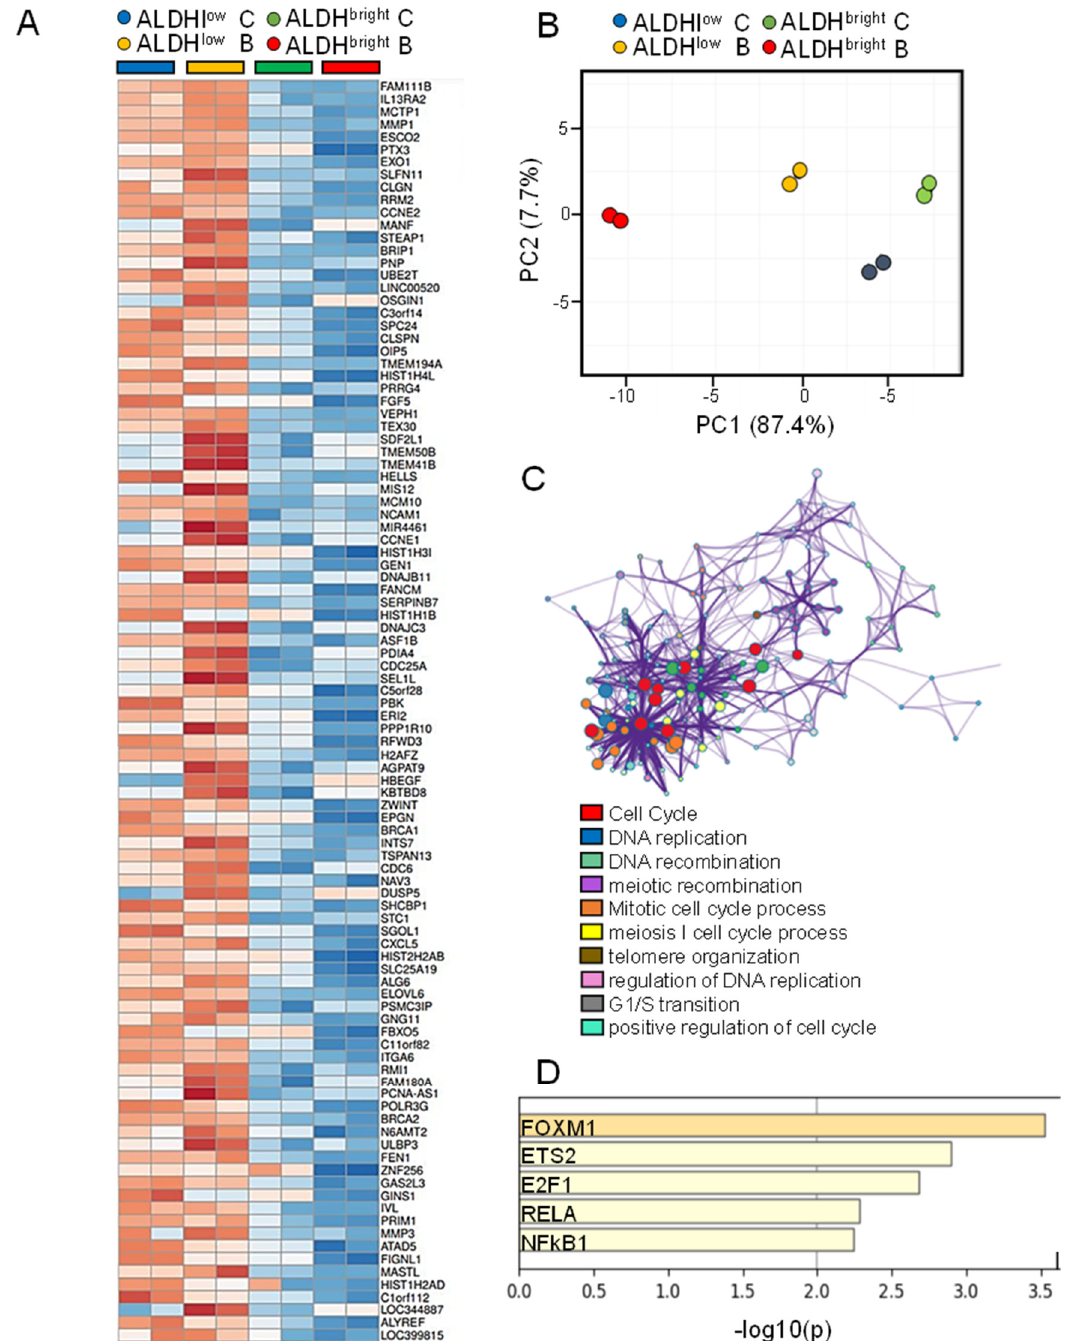
Figure 4. Butein treatment dramatically affected the profile of ALDH bright cells and ALDH low cells : ( A ) representative heat map of the genes significantly modulated more in the ALDH bright cells (when compared to ALDH low cells) after treatment with butein ( B ) for 7 h. log2 expression. p < 0.05, ≥ two-fold modulated mRNAs between butein-treated ALDH bright vs. ALDH low cells. ( B ) PCA plot showing the distribution of the cell subpopulations based on the levels of expression of the genes considered in ( A ). ( C ) Upper panel. The top 10 enriched GO terms between the groups with p < 0.05 are shown. The protein–protein interaction network: each term is represented by a circle node, its size is proportional to the number of input genes. Lower panel. List of the most significantly enriched pathways as from upper panel. ( D ) Histogram showing the most significantly enriched binding sites ( p < 0.05) within the promoters of the analyzed genes.